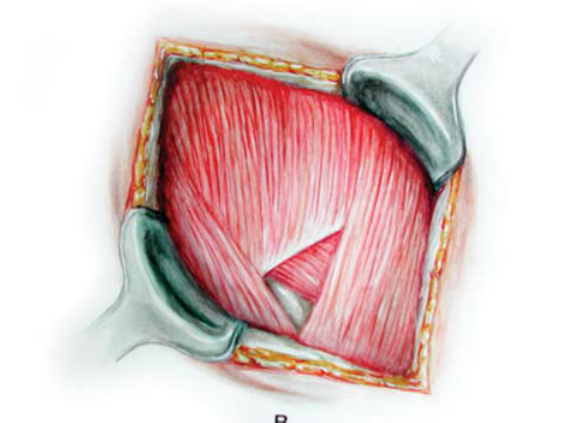
Fig. 2 - Exposição do trígono auscultatório